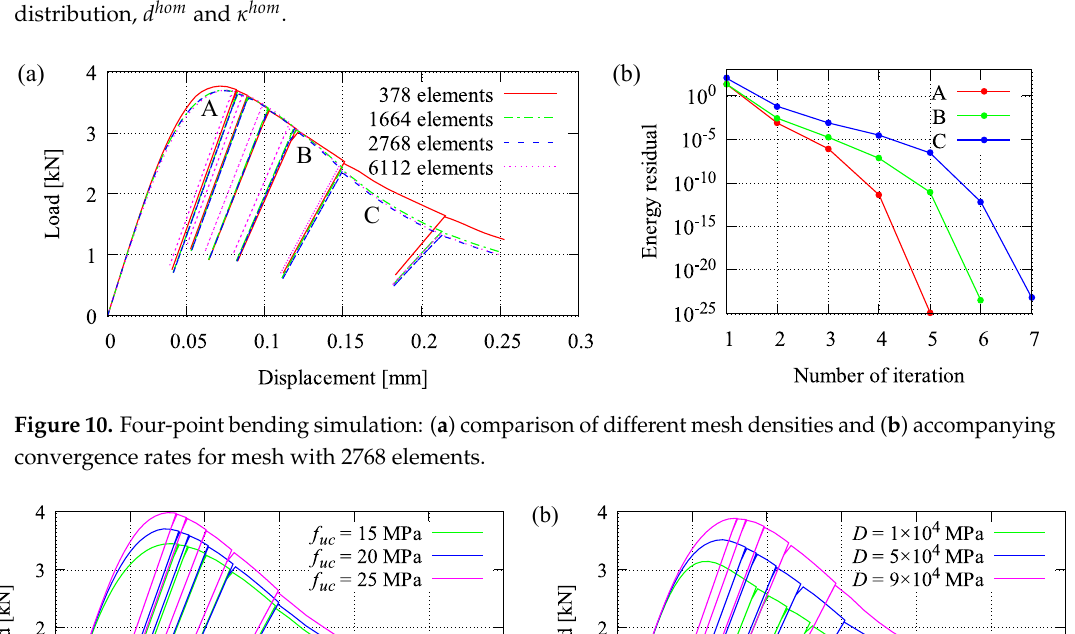
Figure 9. Four-point bending test result: ( a ) load-displacement relation and ( b ) damage and plastic distribution, d hom and κ hom .